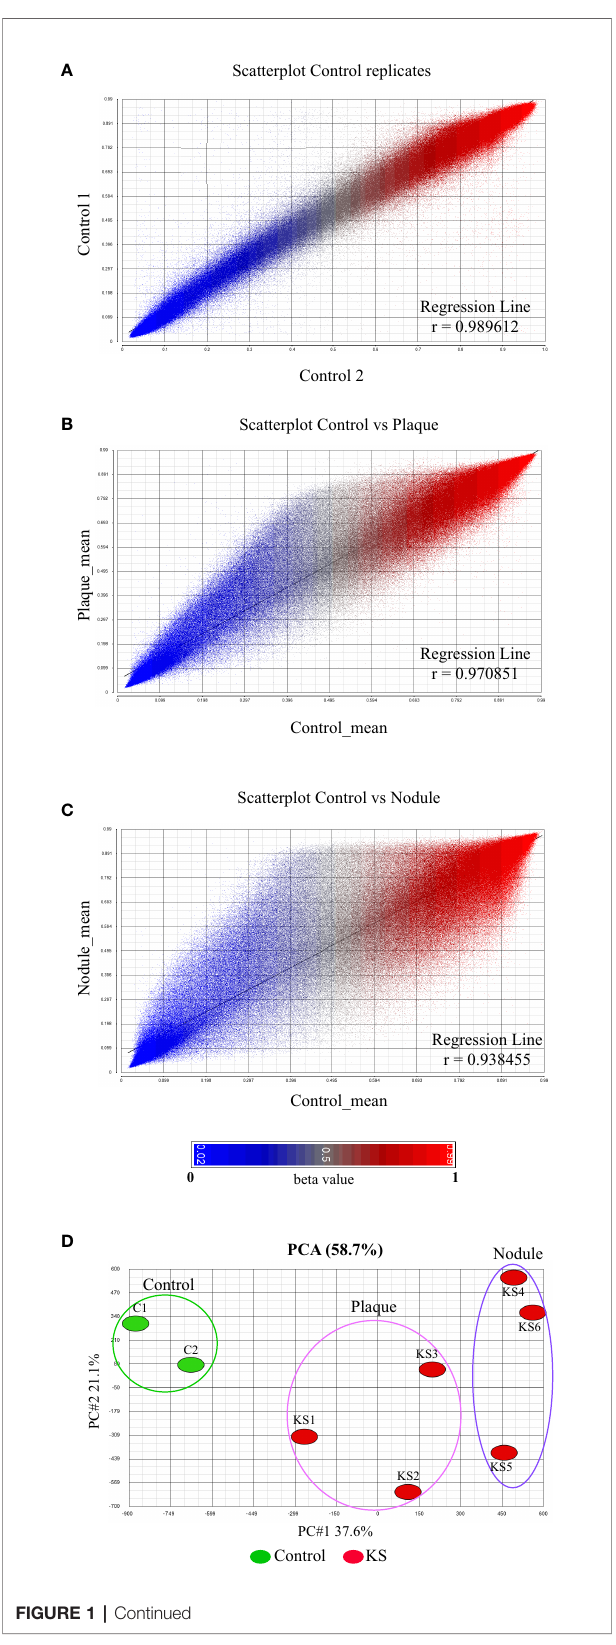
FIGURE 1 | Global DNA methylation clearly distinguishes normal skin from KS. (A – C) The raw b value (presented between 0 and 1) of each CpG probe from the 850K BeadChip is represented by a single dot. Correlation coef fi cient analysis: (A) between biological replicates of uninfected skin controls showing close identity between replicates and (B, C) between uninfected skin control and KSHV infected KS samples at early tumor stage [Plaque (B) ] and late tumor stage [Nodule (C) ]. (D) Principal component analysis of the raw b values from the 850K BeadChip showing the variability between control and